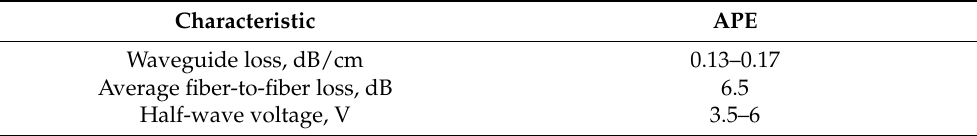
Table 1. Optical losses and half-wave voltage.